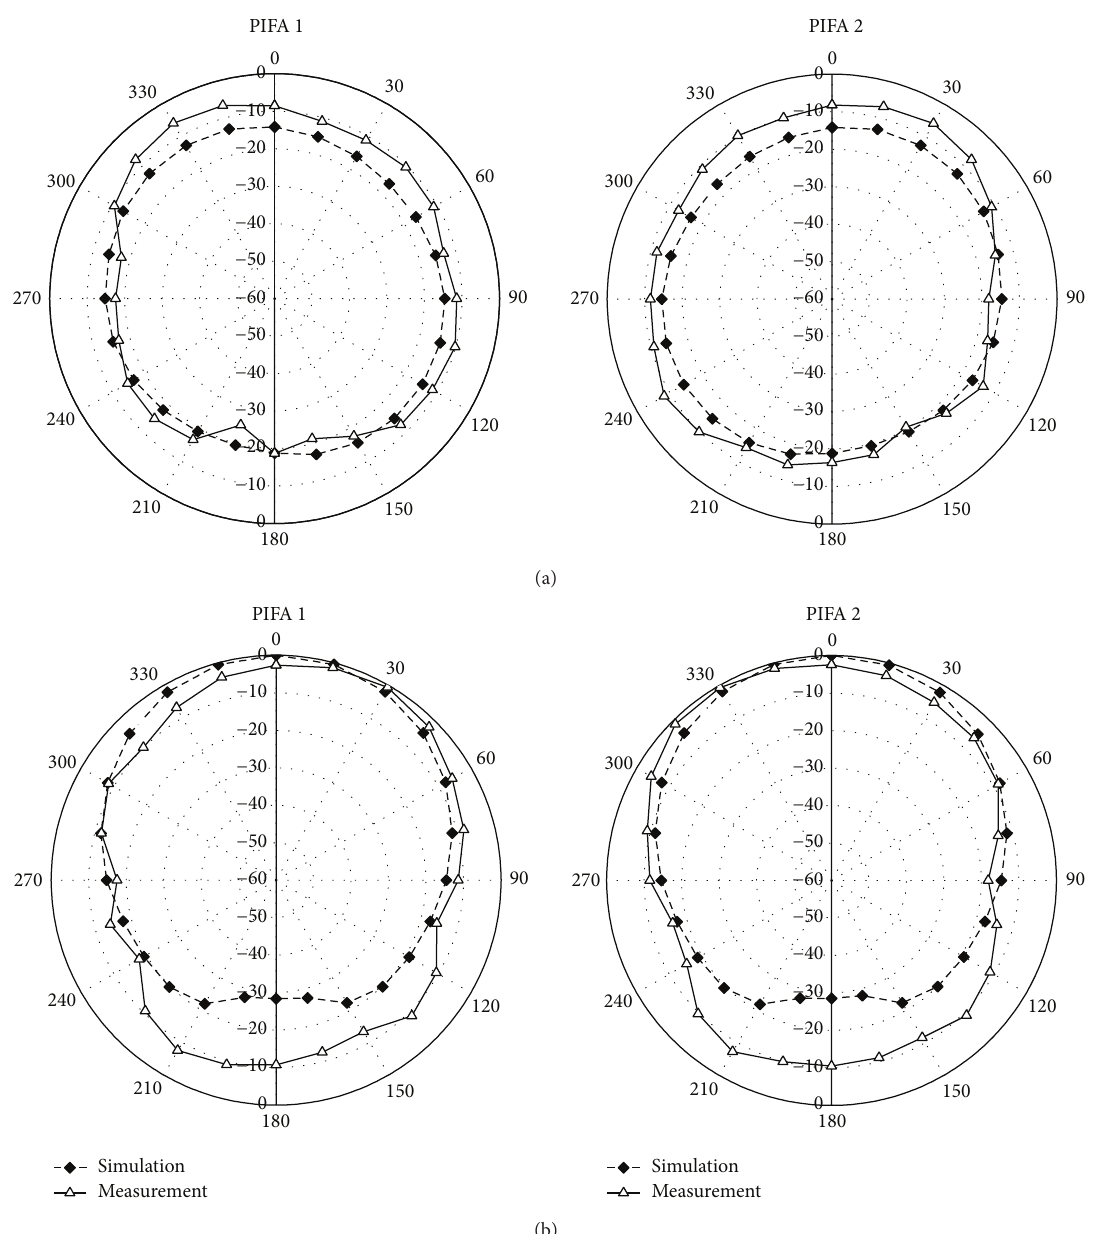
Figure 10: Simulated and measured radiation patterns of the proposed antenna at 2.4 GHz. (a) 𝑥𝑦 plane; (b) 𝑦𝑧 plane ( 𝜎 for simulation: 1.95 S/m, 𝜎 for measurement: 0.94